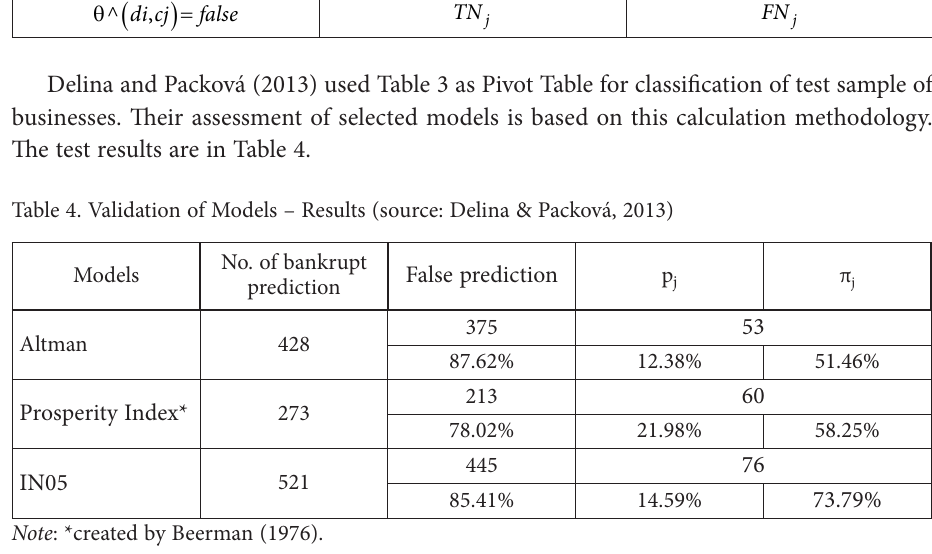
Delina and Packová (2013) used Table 3 as Pivot Table for classification of test sample of